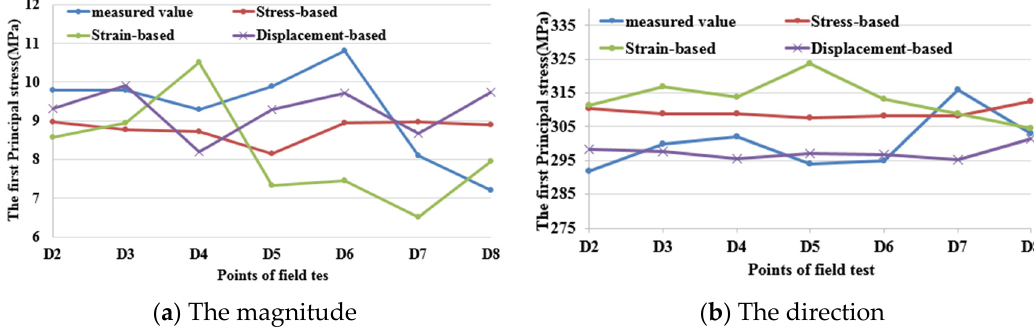
Figure 10. Comparison with measured values of the first principal stress.